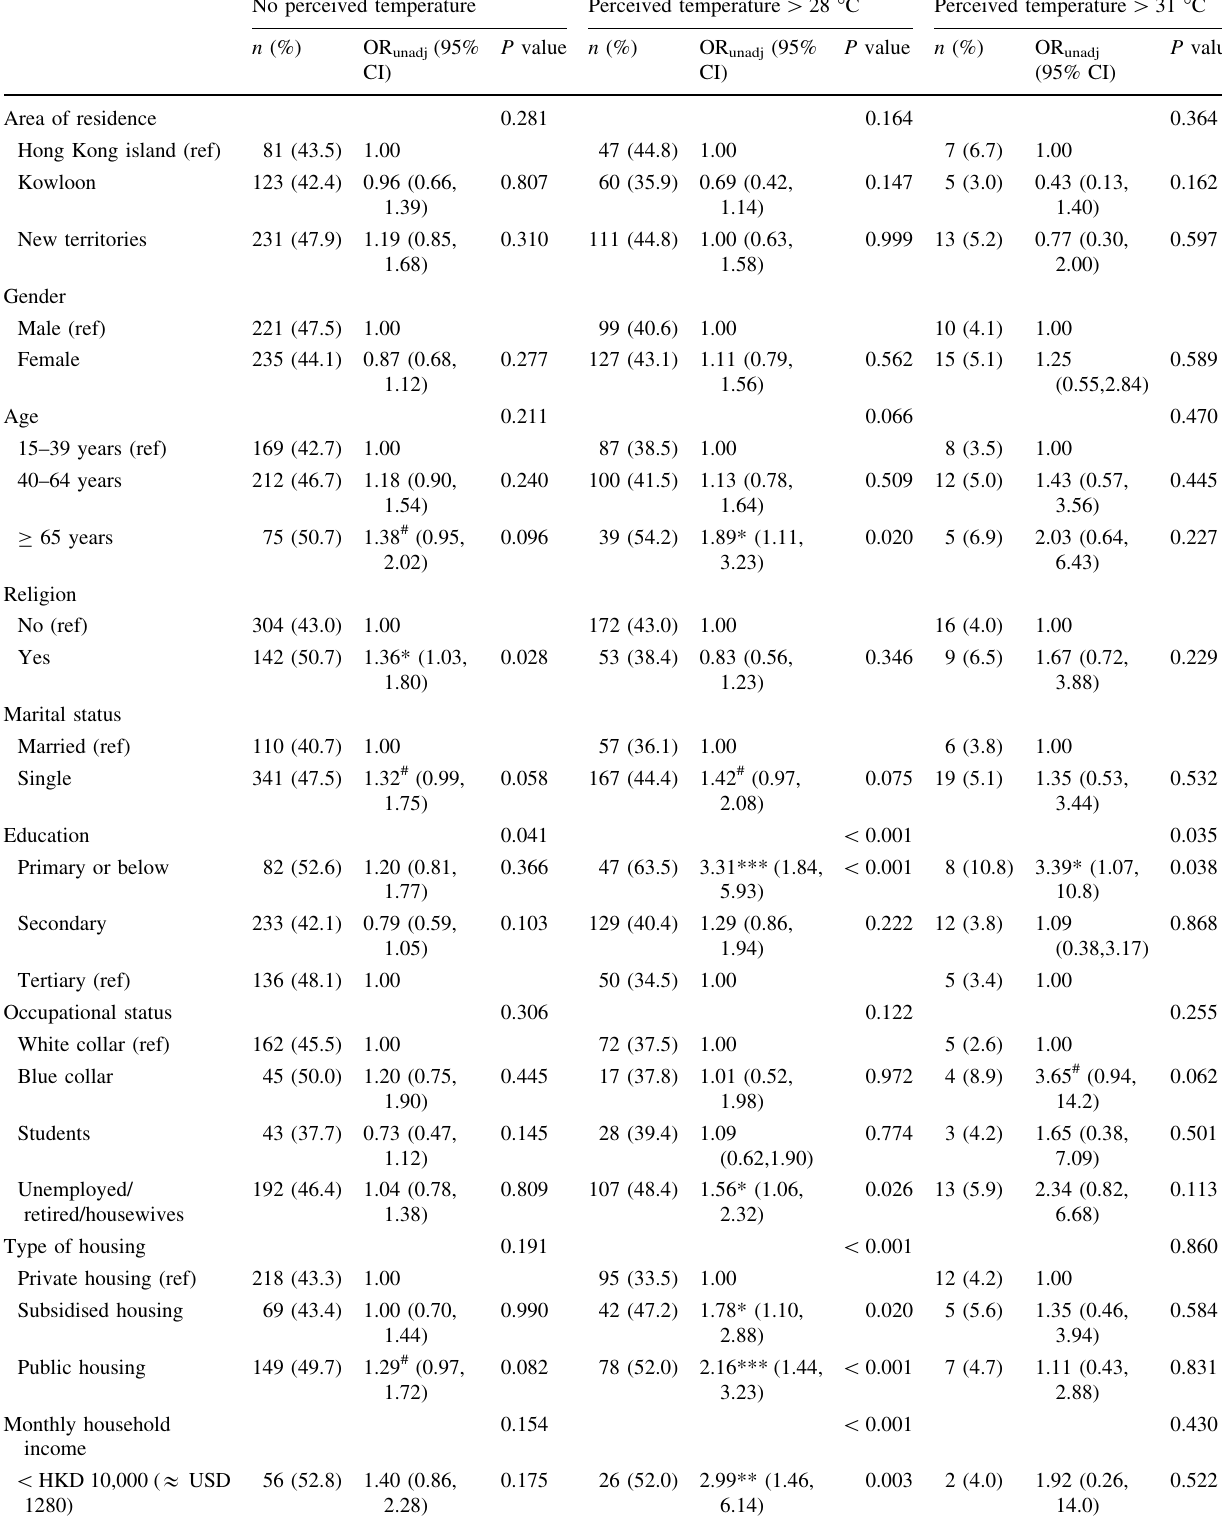
Table 4 Univariate logistic regression for perceived temperature needed to turn on cooling devices at home in the risk perception of climate change health impact survey in Hong